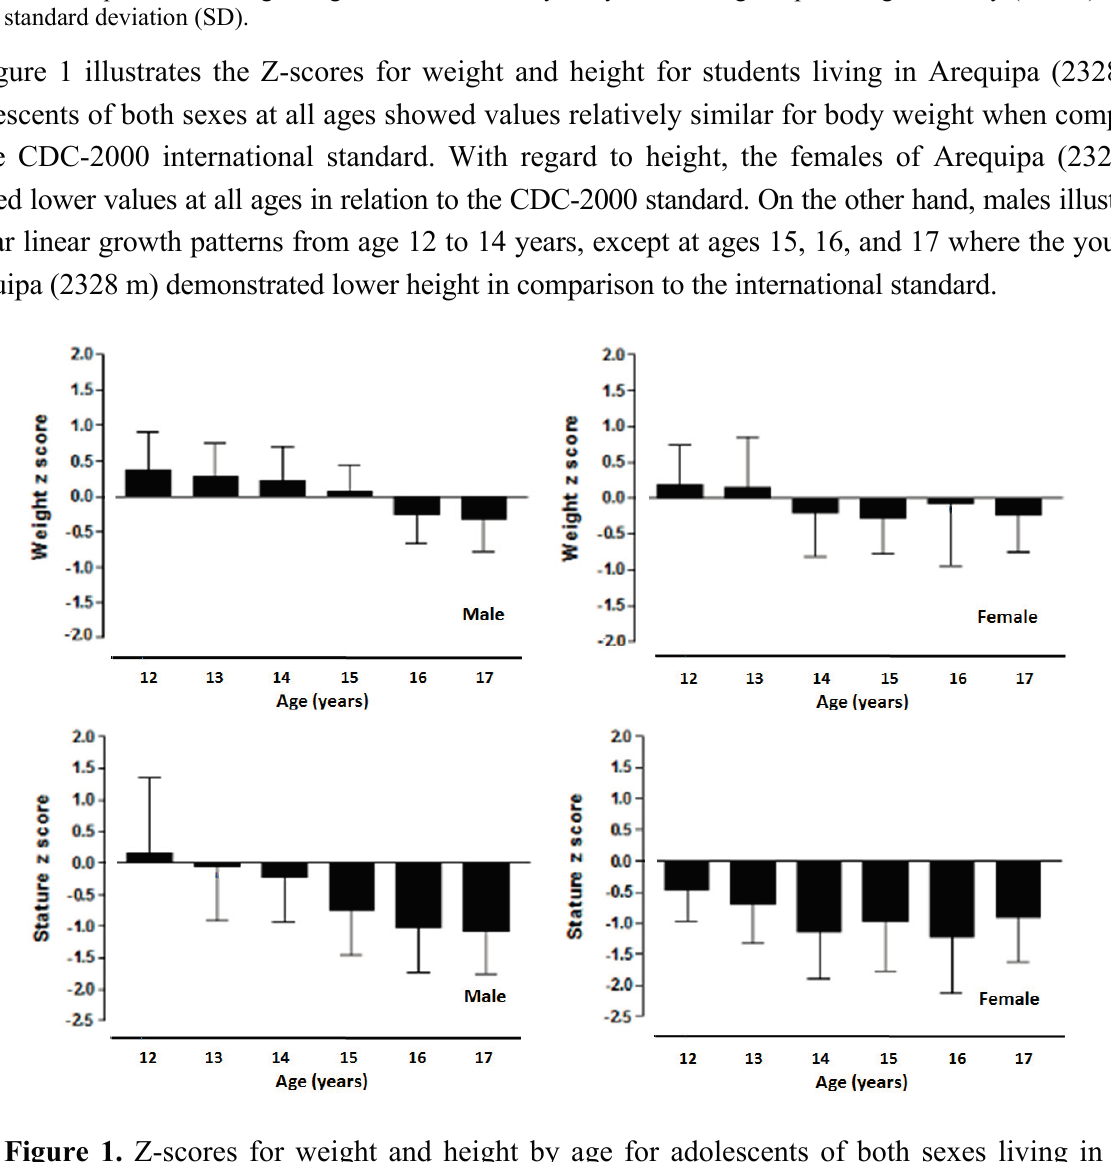
Figure 1. Z-scores for weight and height by age for adolescents of both sexes living in Arequipa (Peru) compared to the CDC-2000